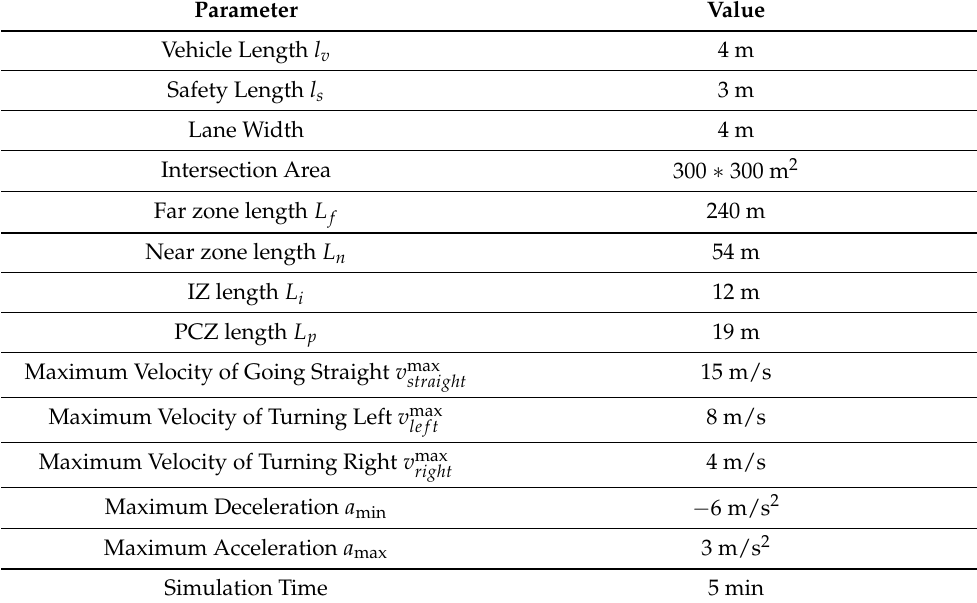
Table 1. Simulation parameters.